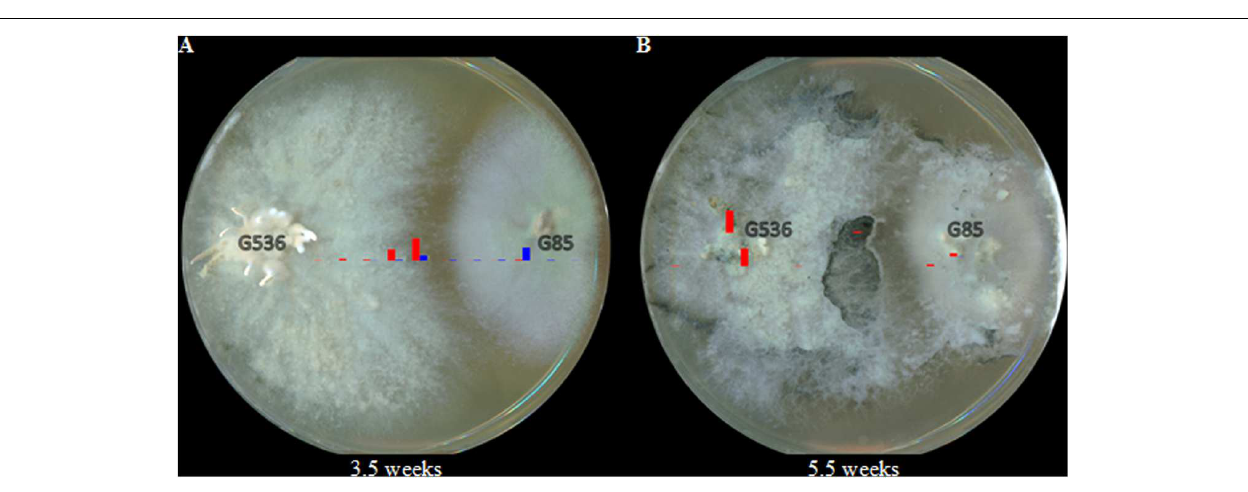
FIGURE 8 | Heat map of griseofulvin (red) and the P. restrictum (G85) metabolites (blue group only; purple metabolites were undetectable) at (A) 3.5 weeks and (B) 5.5 weeks. The heights of the bars are relative to their intensity from the HRMS